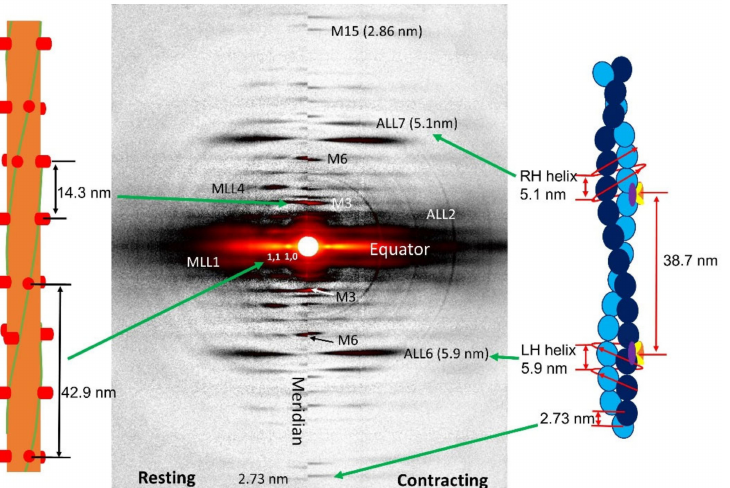
Figure 4. The origin of meridional and layer line reflections. Schematic diagram of the quasi-helical arrangement of myosin heads around the thick filament backbone (left panel) and the double helical arrangement of actin monomers in the thin filament (right panel). The meridional reflections arising from these features are shown in the composite X-ray diffraction pattern (based on reference [24]) in the center panel with the left half from relaxed muscle and the right from contracting mouse soleus muscle. Note that the M6 and higher order myosin meridional reflections come from structures within the thick filament backbone (not shown on the figure).